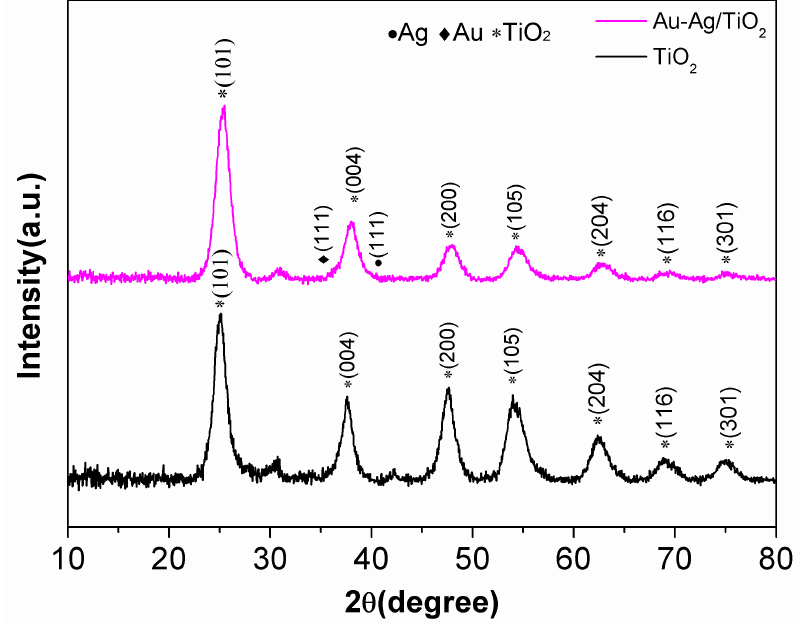
Figure 1. XRD pattern of pure TiO 2 and 1.18 wt% Au-1.07 wt% Ag decorated TiO 2 particles.